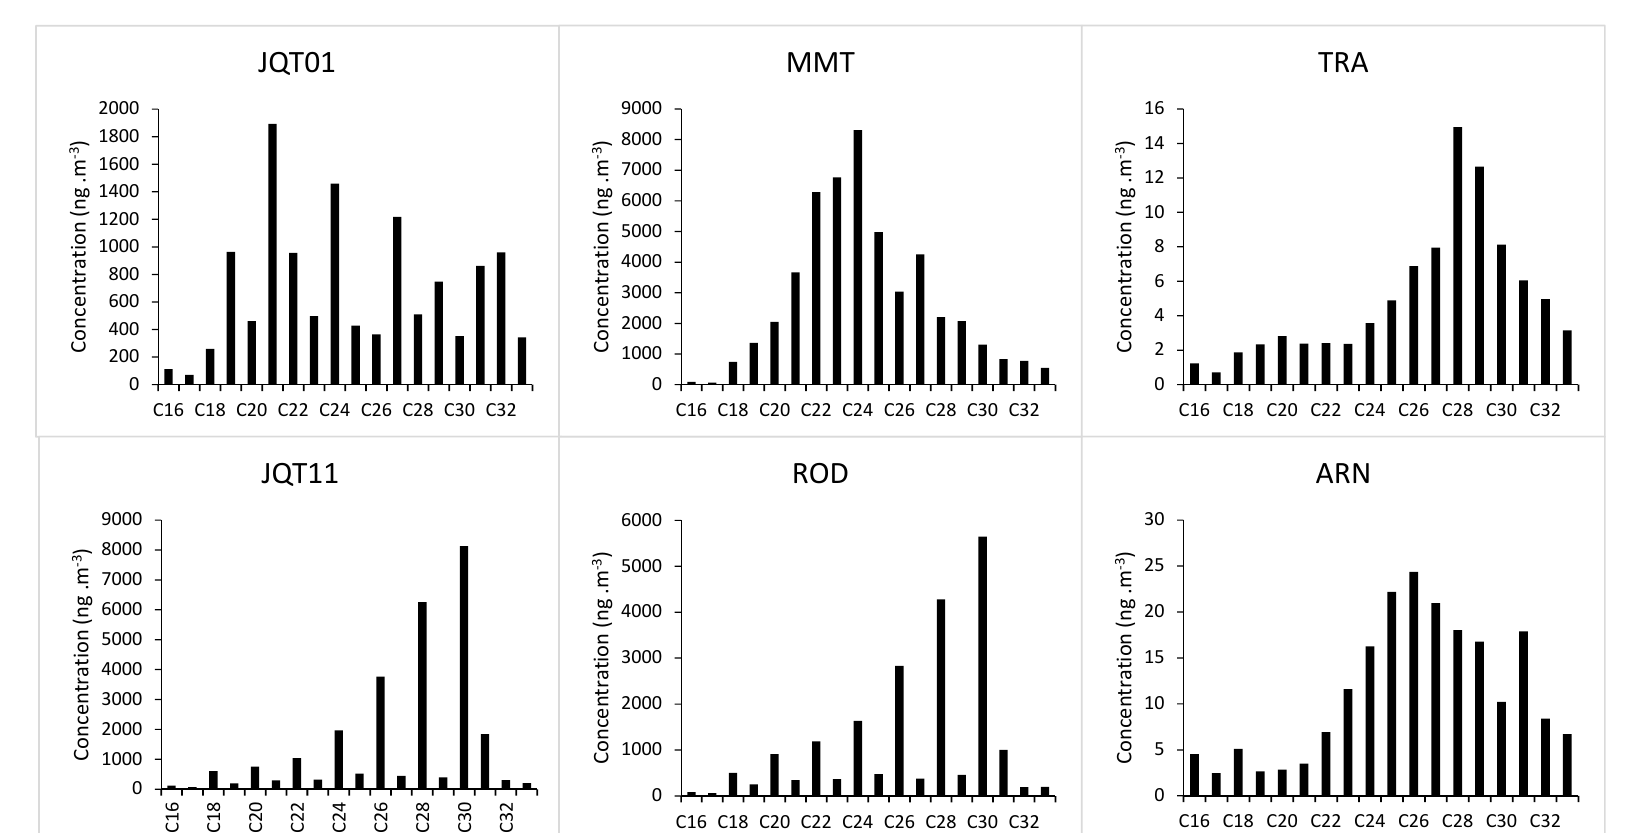
− 3 ) for ( a ) Salvador and ( b ) S ã o Paulo Figure 2 . n -alkanes distribution (ng m-3) for (a) Salvador and (b) São Paulo sites Figure 2. n -alkanes distribution (ng m